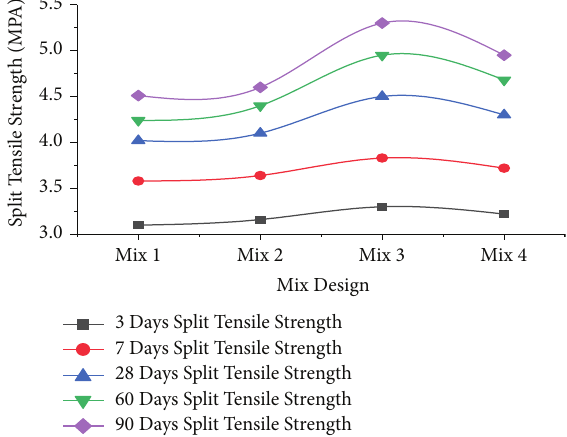
Figure 7: Graph of tensile strength for different mixes. Figure 9 refers to the XRD graph of mix 2. The results were well in agreement with the XRF results. The peak at 2 θ � 13 ° was attributed to kaolinite. Metakaolin was not observed in the pattern due to its amorphous nature. The